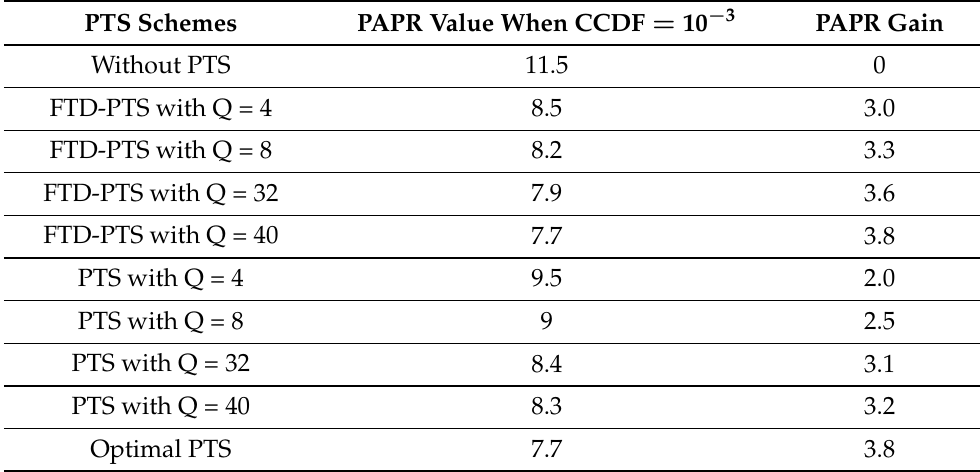
Table 6. The PAPR reduction performance comparison of FTD-PTS and conventional PTS when CCDF = 10 − 3